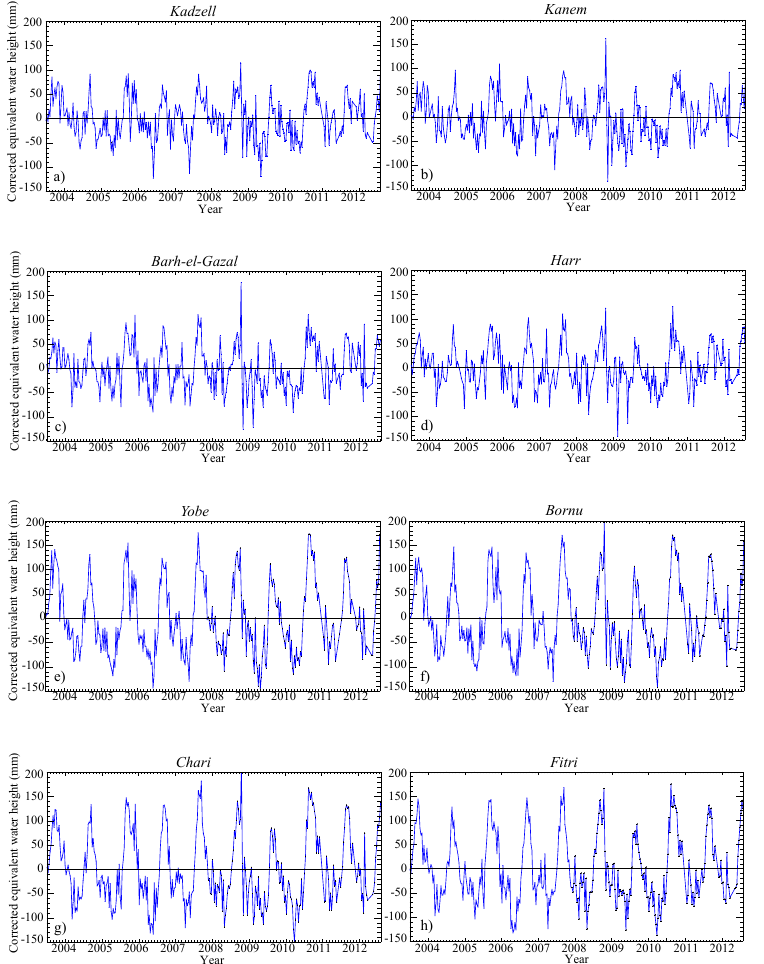
Figure 2. Equivalent-water height for GRACE tiles (see locations in Figure 1). For each time series, a computed trend has been removed from the GRACE